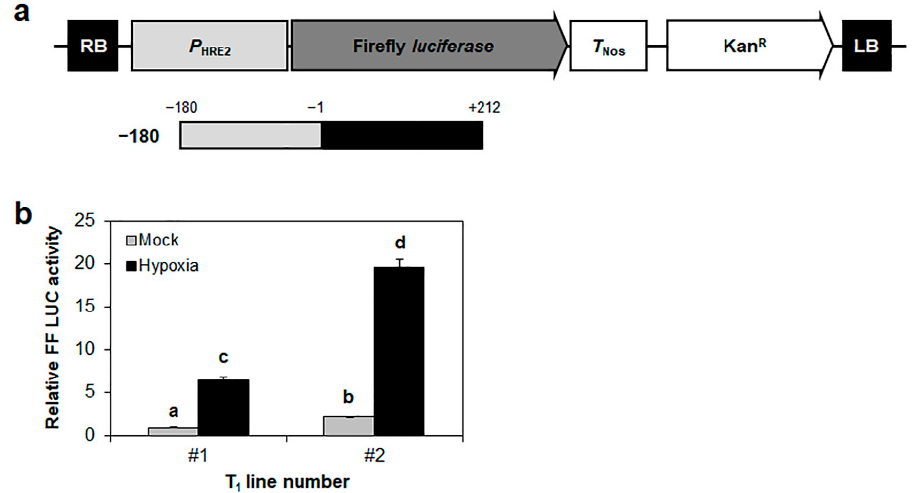
Figure 2. Validation of luciferase assay under hypoxia using Arabidopsis transgenic plants. ( a ) A schematic map of vector for HRE2 promoter activity analysis. ( b ) Relative firefly luciferase activity in Arabidopsis transgenic plants after being subjected to hypoxia. Hypoxia was induced using N 2 gas for 12 h. Firefly luciferase activity of mock in line number 1 was set as 1. Data are shown as means ± S.D. ( n = 3). Different letters display significant differences ( p < 0.05). Mock indicates normal condition.